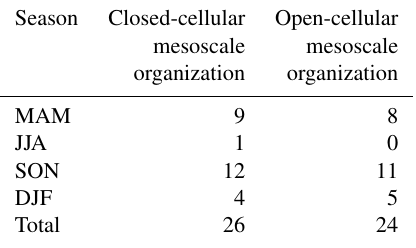
Table 2. Summary of open- and closed-cell cases used in this study for each season (MAM: March, April, and May; JJA: June, July, and August; SON: September, October, and November; DJF: December, January, and